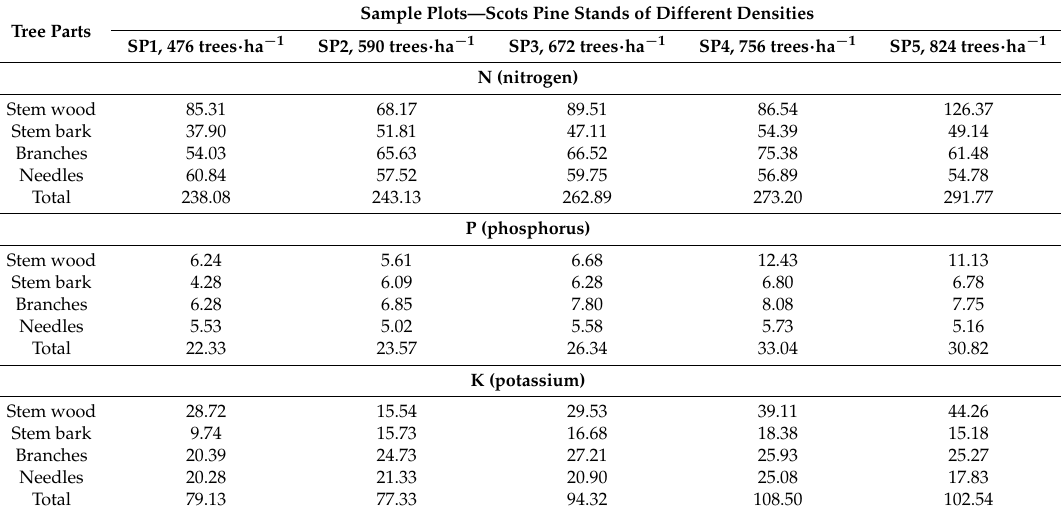
Figure 3. Average concentrations of macronutrients in tree compartments (SW—stem wood, SB—stem bark, BR—branches, FL—foliage) in model trees (N = 15) divided into small, medium, and big trees (according to DBH). Oblique lines show in which compartments the concentration of macronutrients was significantly correlated ( p < 0.05) with tree size. All correlations were negative. Table 4. Macronutrient stocks (kg · ha − 1 ) in stem wood, stem bark, branches, needles, and total (all aboveground biomass) for Scots pine stands of different